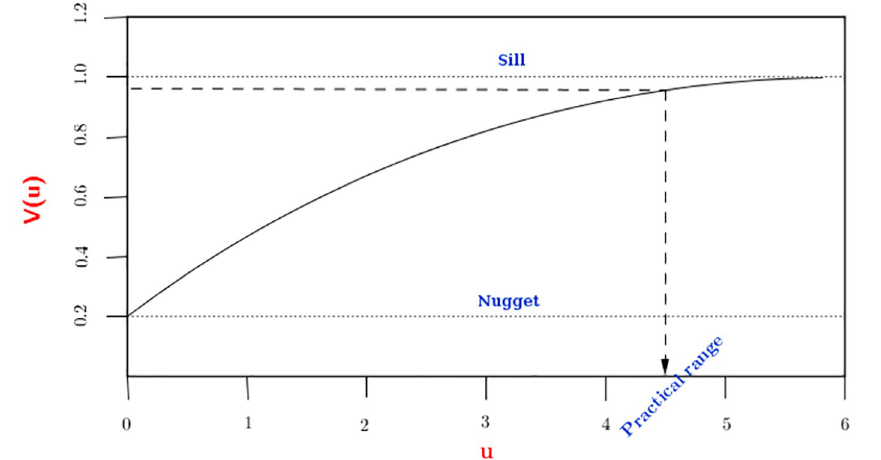
Fig 1. Plot of the theoretical variogram and its main